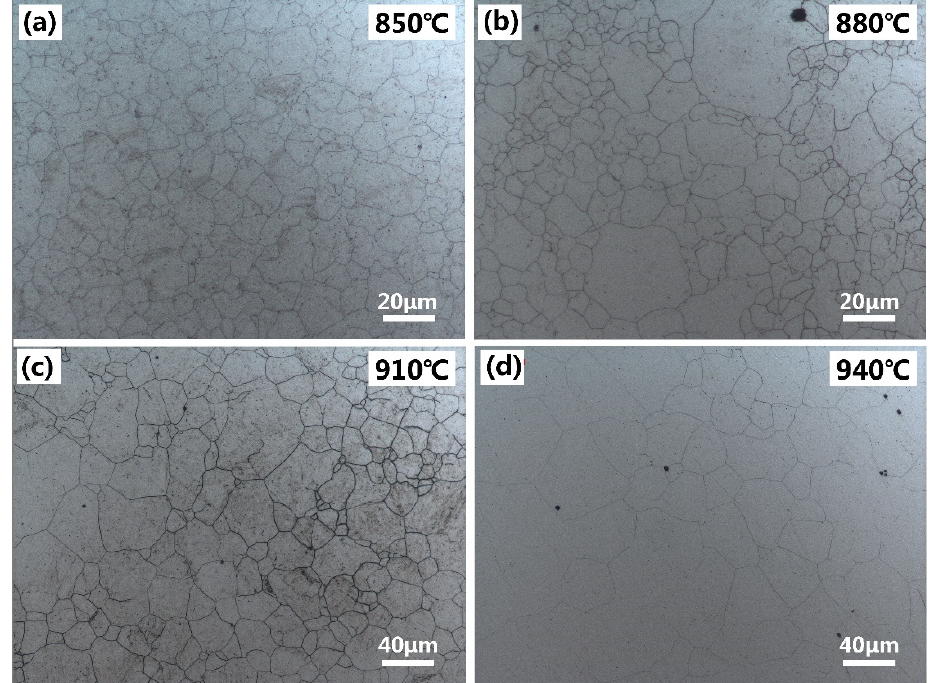
Fig. 2. Prior austenite grain of MCLA martensitic steel austenitized at the different temperatures of